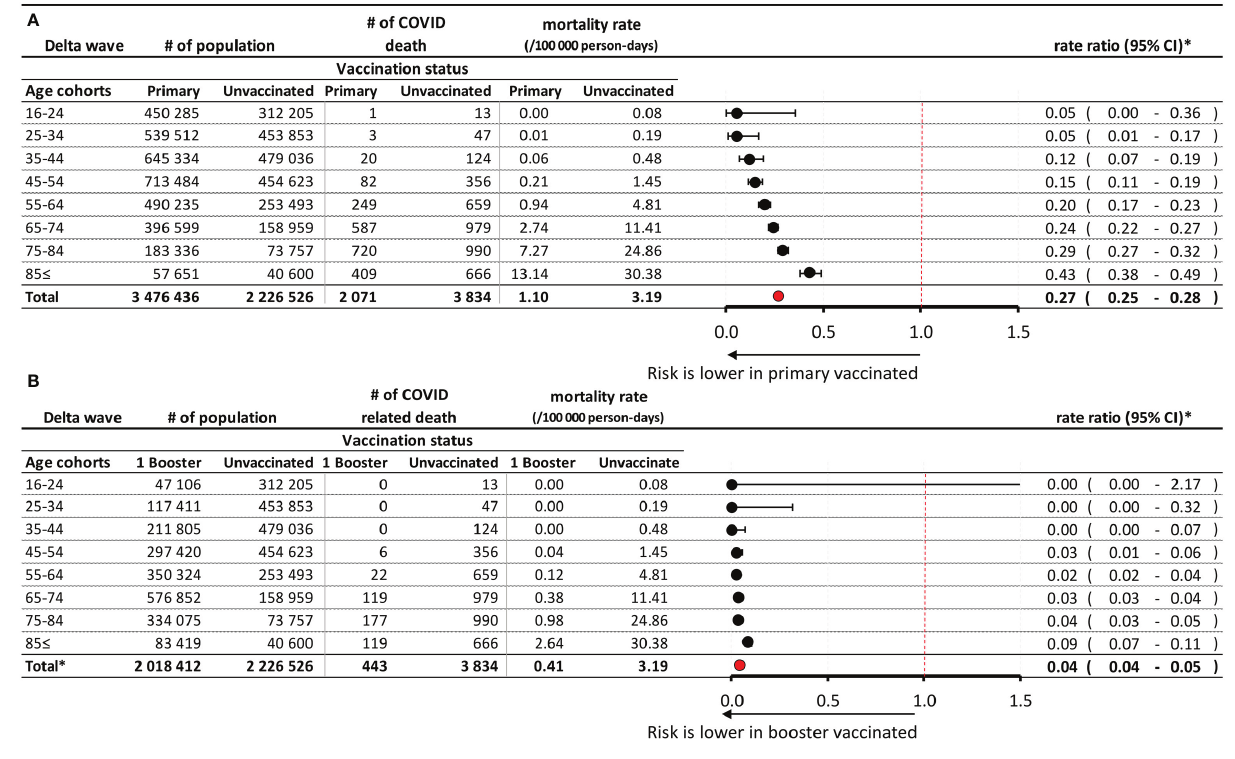
FIGURE 2 | Risk of Covid-19 related mortality during the Delta wave in the primary immunized vs. unvaccinated control population (A) , and in the booster vaccinated vs. unvaccinated control population (B) , according to age. *Exact con fi dence intervals for age-speci fi c mortality rate ratios and Mantel-Haenszel pooled mortality rate ratio for the total population adjusted for